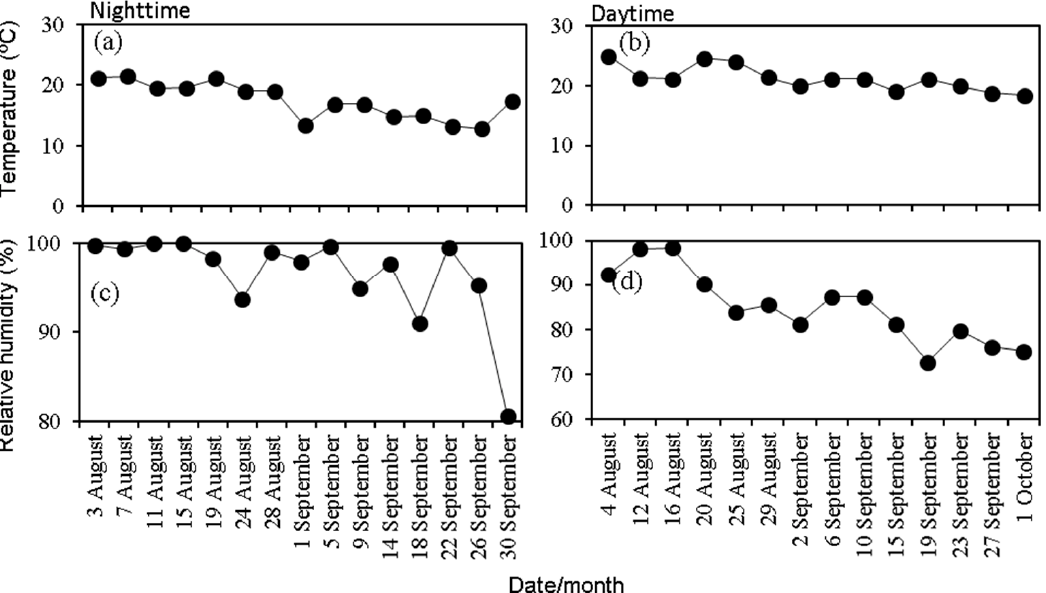
Figure 2. Ambient temperature and relative humidity during ( a , c ) nighttime and ( b , d ) daytime. The original meteorological data were collected at the sampling site.